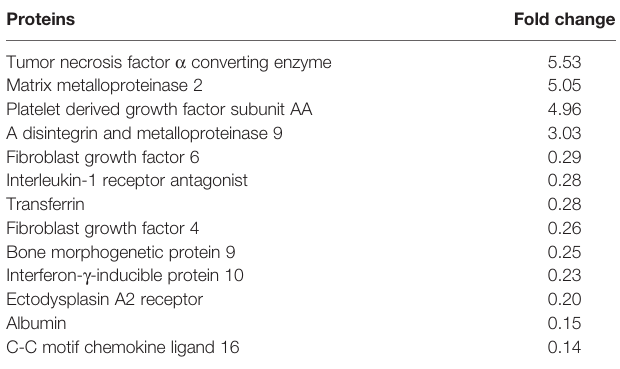
TABLE 3 | Protein array analysis of dysregulated proteins in three overexpressing Circ_0088194 RA-FLSs compared with three control